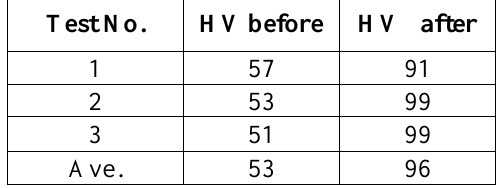
Table 3: Average micro-hardness, before LST and after LST. Test No. HV before